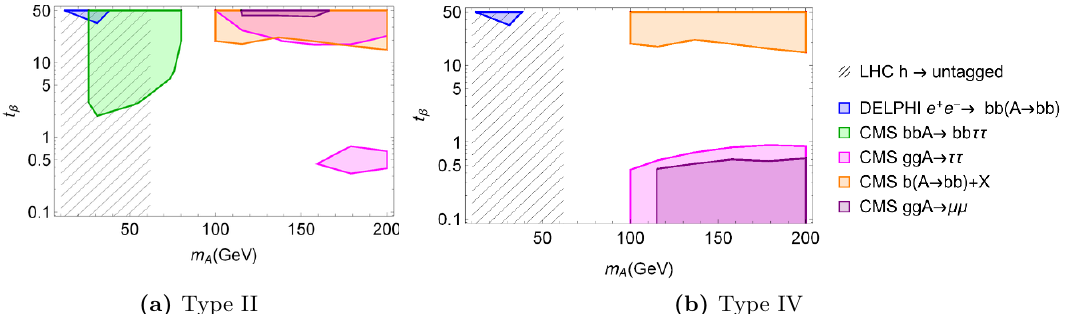
Figure 3. Excluded regions in the t (cid:12) (cid:0) m A plane for (a) Type II and (b) Type IV models, at 95% C.L. from various measurements at LEP and the